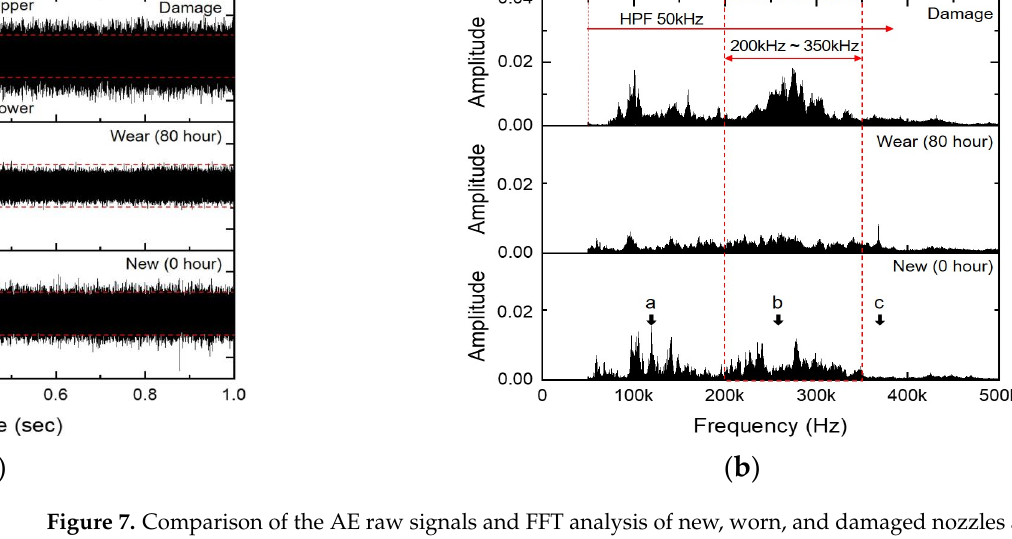
Figure 7. Comparison of the AE raw signals and FFT analysis of new, worn, and damaged nozzles at a waterjet pressure of 300 MPa and an abrasive feed rate of 350 g/min: ( a ) AE raw signals and ( b ) FFT signals.